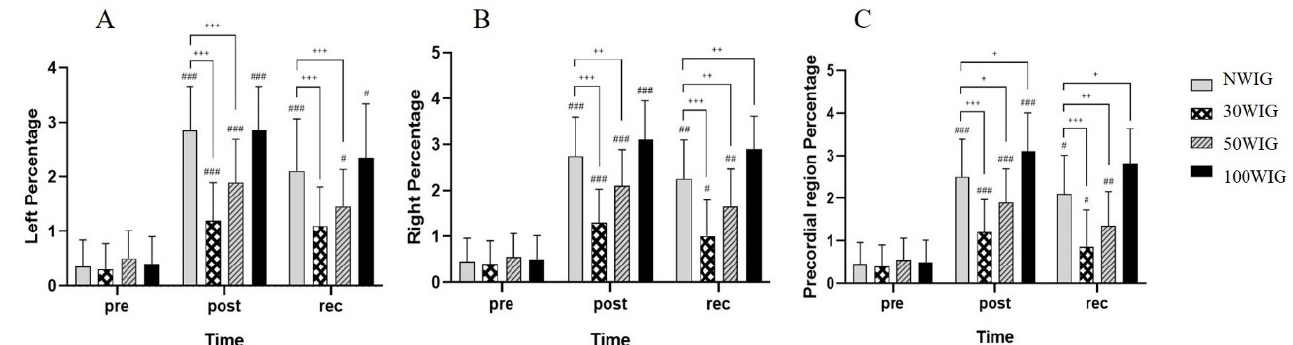
Figure 2. Comparison of percentage in the left subclavian vein ( A ), right subclavian vein ( B ), and the precordial region ( C ). Following ANCOVA, Bonferroni post hoc analysis was conducted to specify protocol effect. NWIG, no-water-intake group; 30WIG, 30%-water-intake group; 50WIG, 50%-water-intake group; 100WIG, 100%-water-intake group. The data are represented as mean ± SD. *, **, and *** represent p ≤ 0.05, p ≤ 0.01, and p ≤ 0.001, respectively, when compared to NWIG at post-dive (post). # , ## , and ### represent p ≤ 0.05, p ≤ 0.01, and p ≤ 0.001, respectively, when compared to NWIG at 30 min into recovery time (rec).